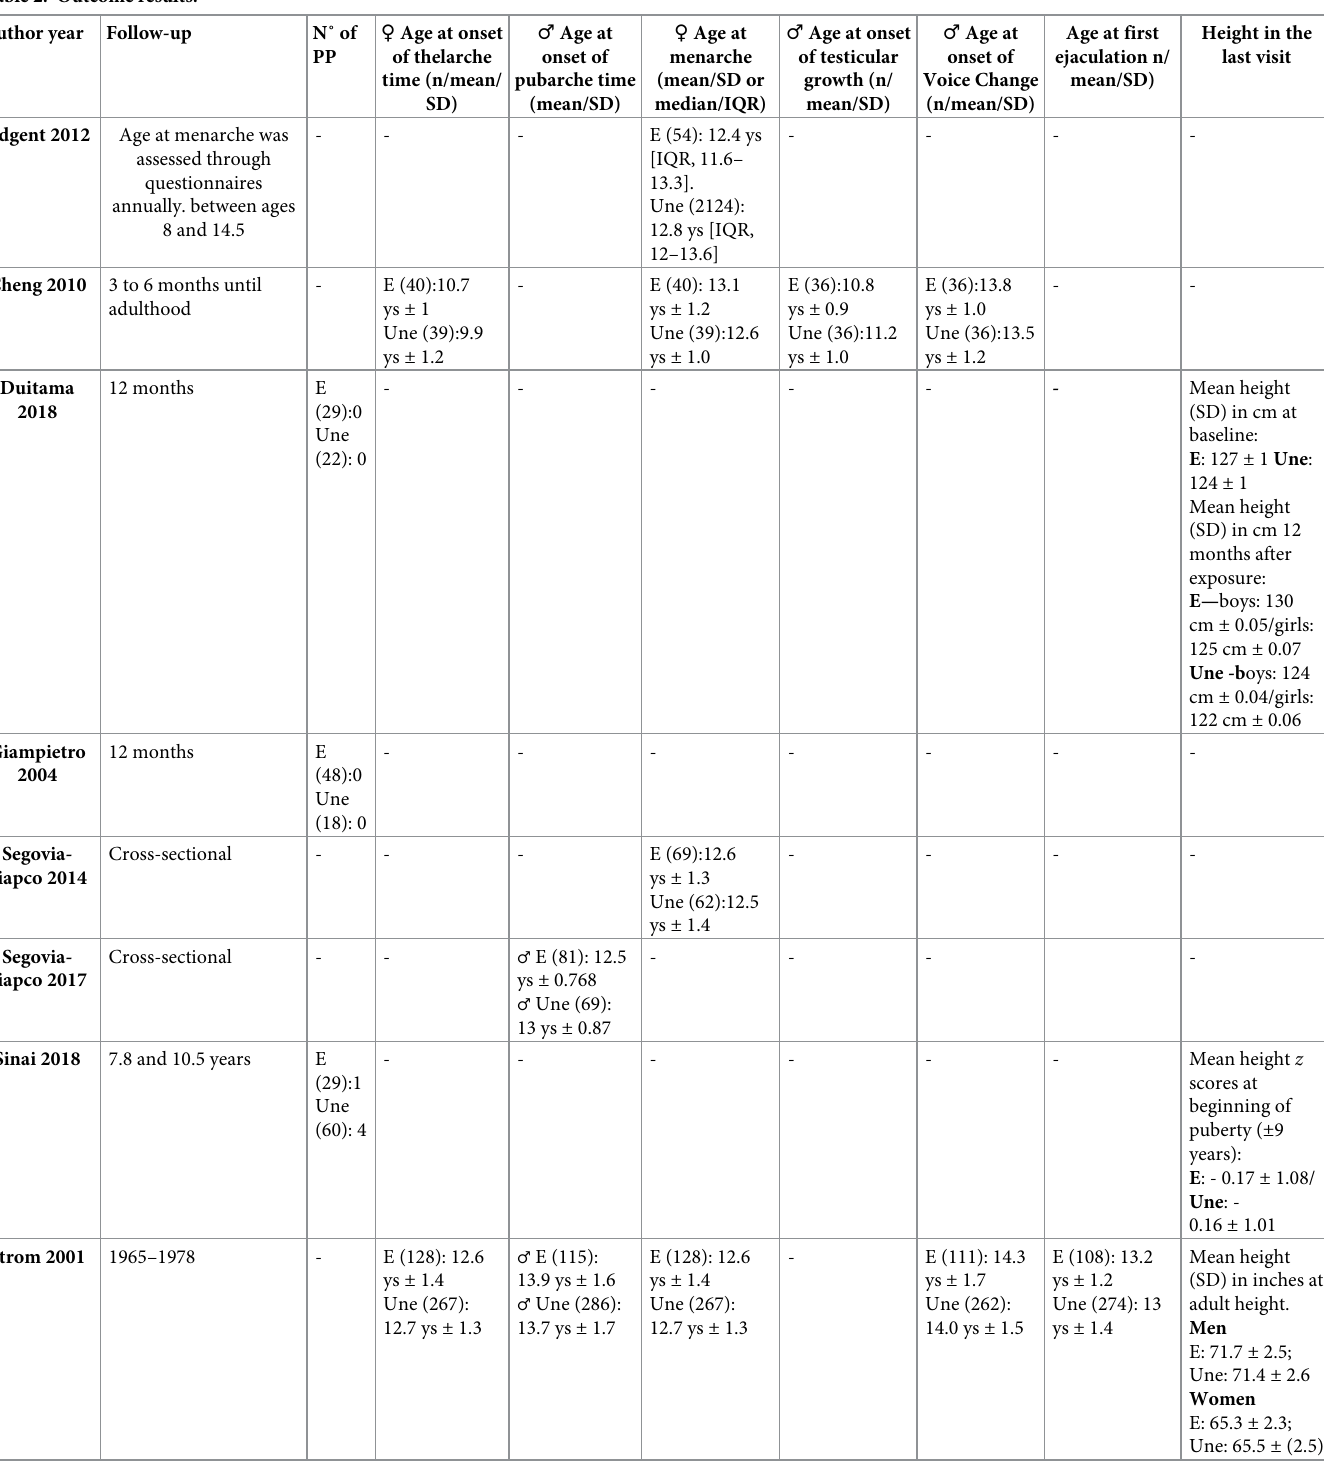
Table 2. Outcome